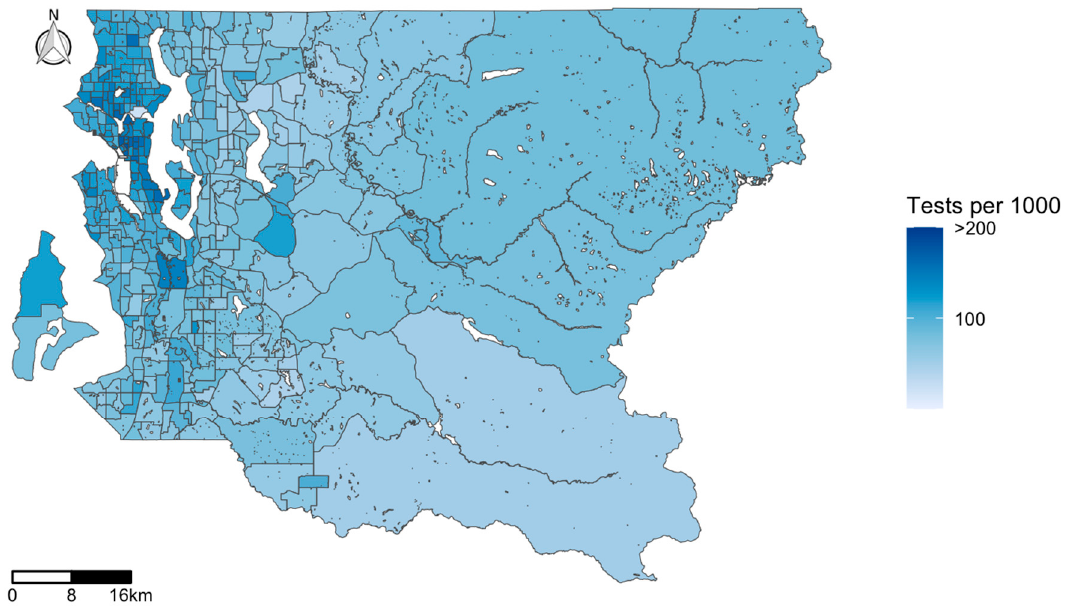
Figure 2. Map of COVID-19 testing (tests per 1000 population) by census tract in King County, WA, USA.